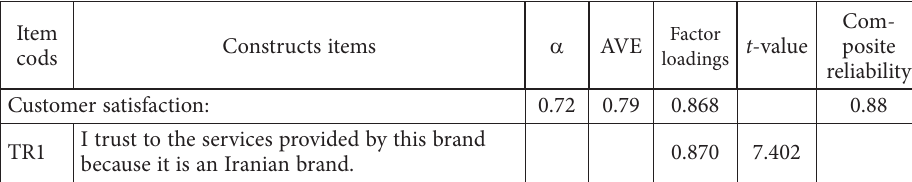
Table 2. Constructs and measuring